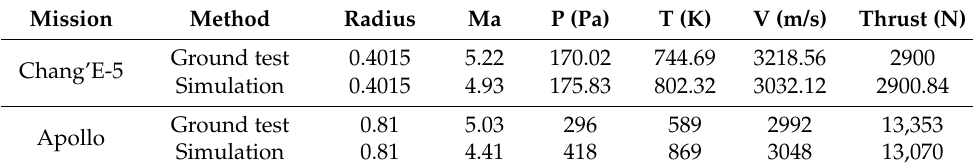
Table 1. Nozzle exit plane flow properties in Chang’E-5 and Apollo missions [21,35].